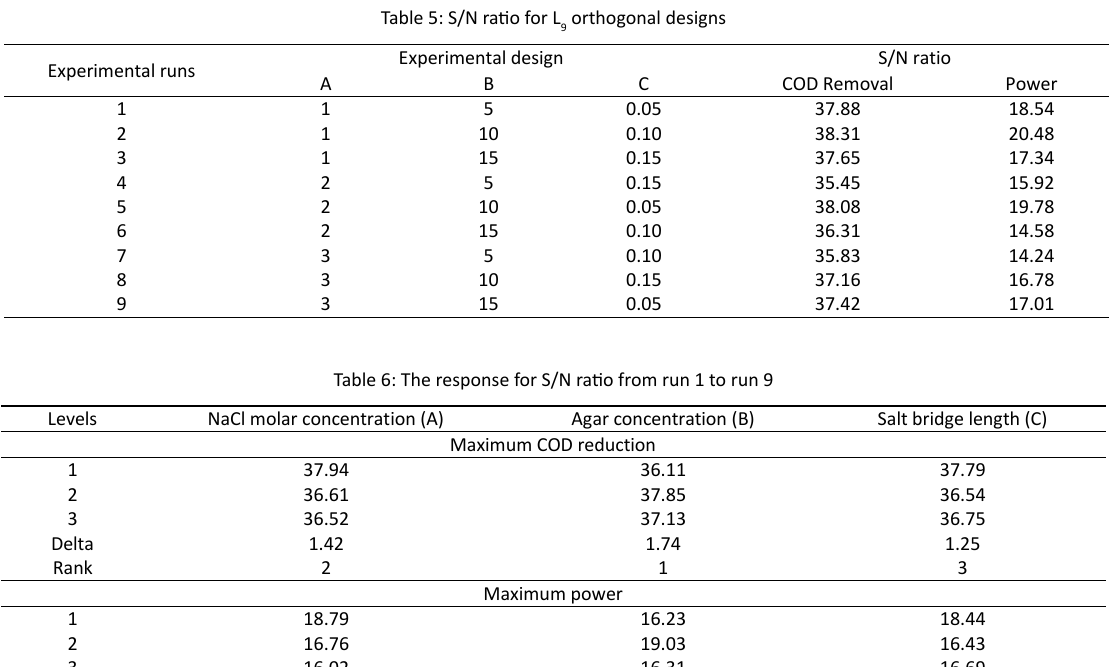
Table 5: S/N ratio for L 9 orthogonal designs